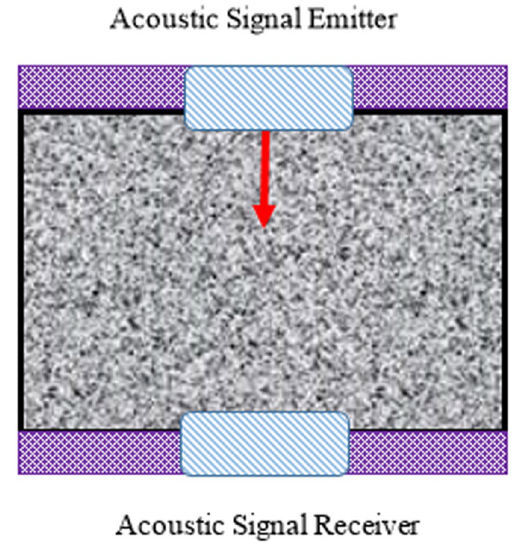
Fig. 24 Schematics of the ART setup (Jamaluddin et al.